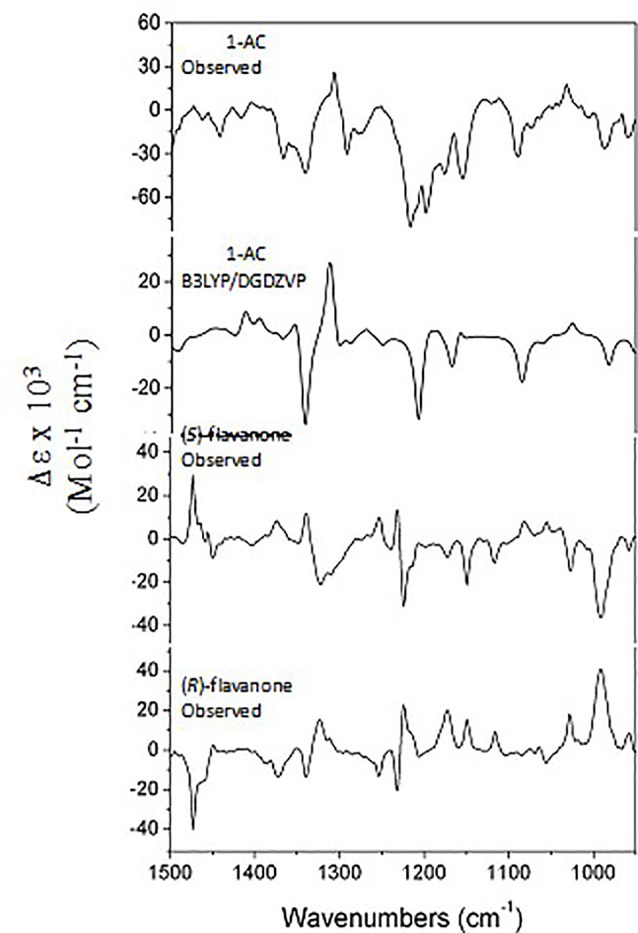
Comparison of the observed VCD spectrum of (-)-(S)-1AC with the B3LYP/DGDZVP calculated spectrum for the (S) enantiomer, and the observed spectra of (S)- and (R)-flavanone. The calculated spectra include an anharmonicity factor of 0.972.